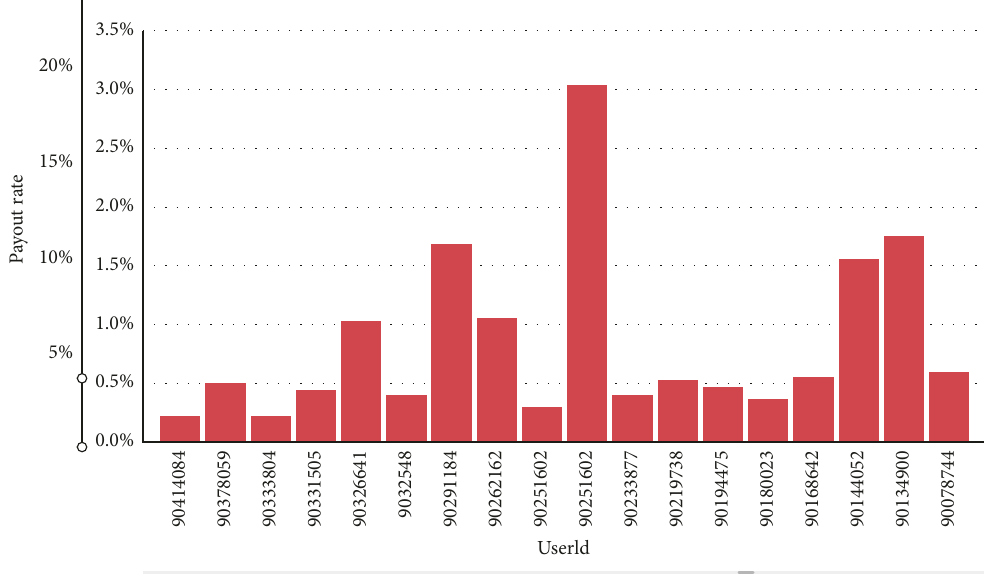
Figure 21: Payment rate of individual users.